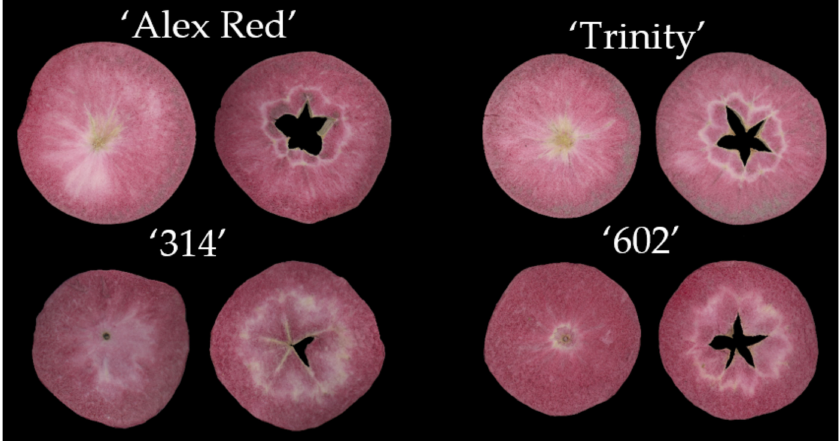
Figure 1. The exemplary color images of freeze-dried slices of ‘Alex Red’, ‘Trinity’, ‘314’, and ‘602’ red-fleshed apple